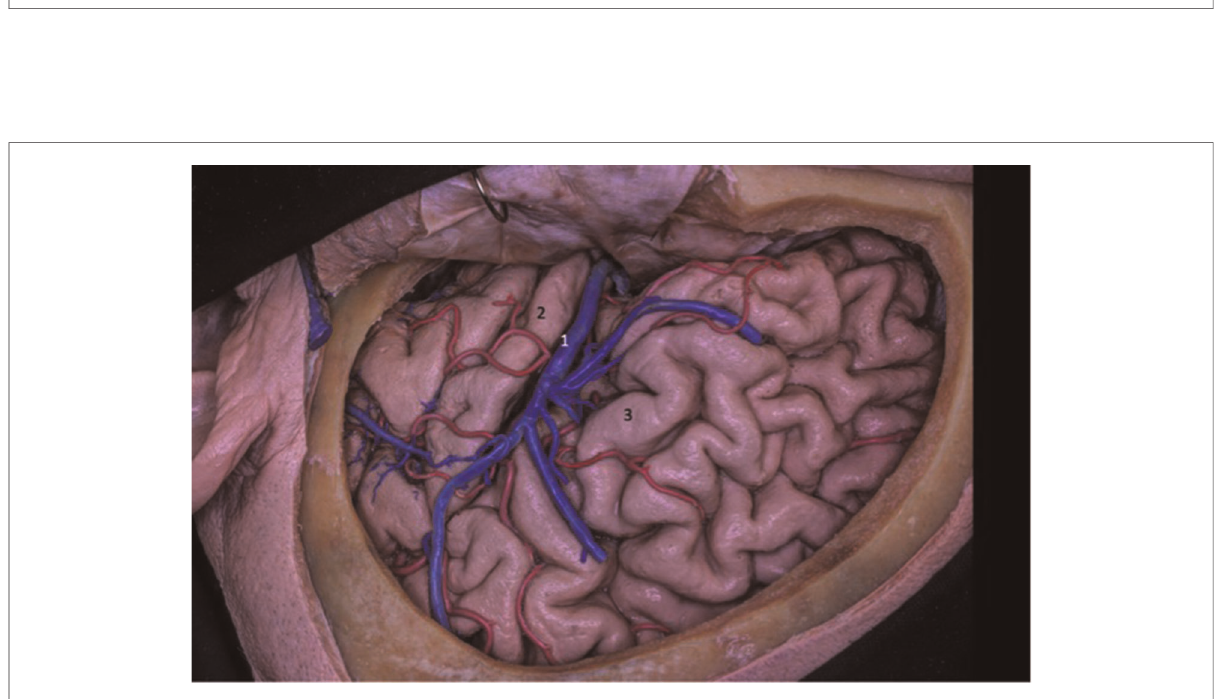
FIGURE 4 The insula is located on the fl oor of the sylvian fi ssure. To access the insula, the fi ssure must be dissected along its entire length. The insula can also be accessed through corticectomy in the inferior frontal gyrus or superior temporal gyrus, commonly after cortical and subcortical mapping with